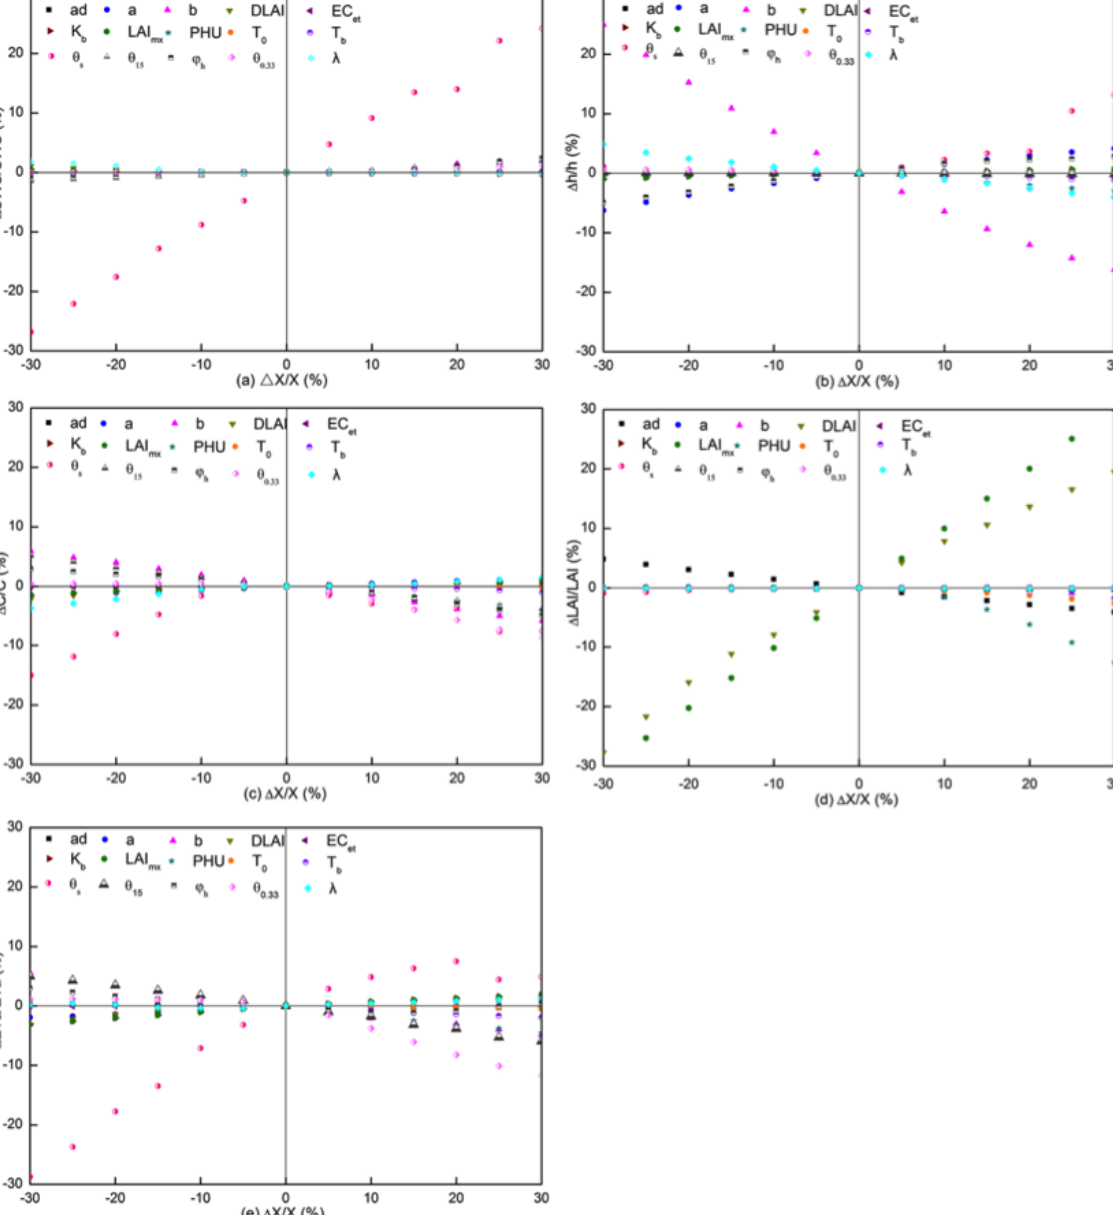
Figure 10. Parameter sensitivity analysis for (a) soil moisture content, (b) groundwater depth, (c) salt salinity concentration, (d) LAI, and (e)